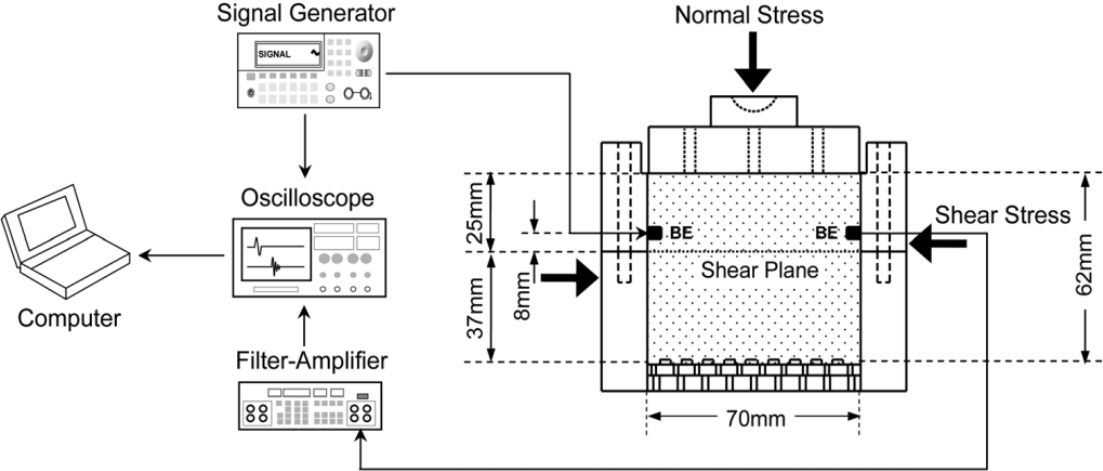
Figure 21. Direct shear box and peripheral electronics. BE denotes bender elements (after [73], with permisson from 2021 ASTM International—License Number 5062700491354 ) .